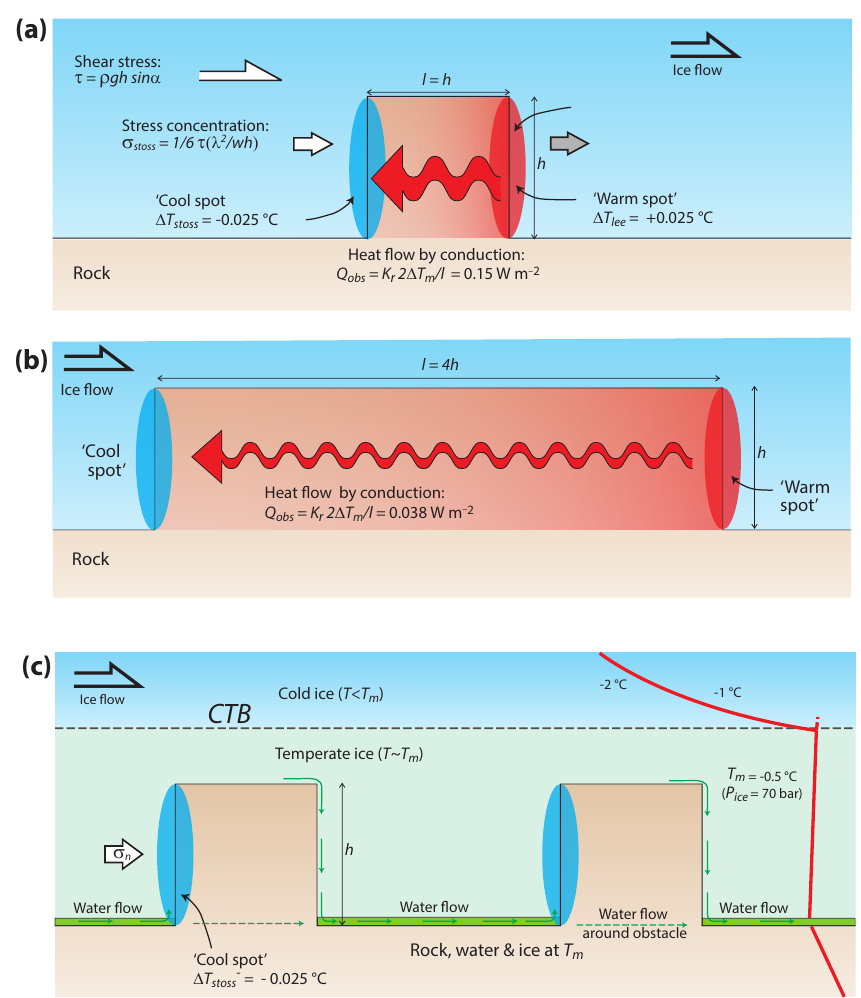
Figure 5. (a) Basic Weertman sliding model, illustrating components of pressure melting. Thermal gradient through bedrock obstacle is indicated by red arrow. (b) Weertman sliding pressure melting with an elongate obstacle; all other parameters are the same. (c) Pressure melting, water and heat transport in a temperate basal layer with significant meltwater flow; a thermal equilibrium occurs everywhere by heat advection by flowing water except at the “cool spot” of the stoss side. CTB is the cold-temperate ice boundary. Schematic thermal gradient of Borehole D is indicated (after Lüthi et al., 2002). See Appendix A for calculations of values in the figure.